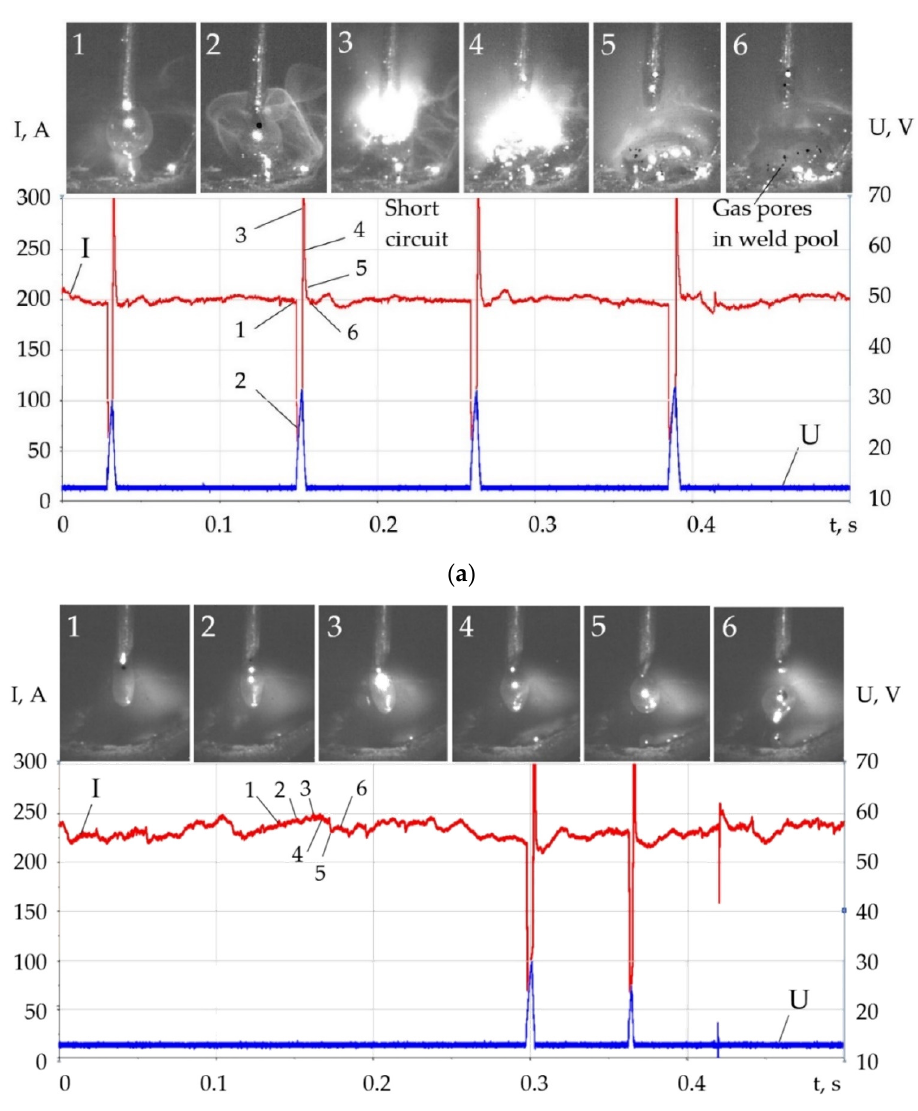
Figure 12. Change in the current and sequence of droplet transfer during melting of a 316L wire of 1.0 mm in argon: ( a ) uncoated wire; time between the frames is 1 ms; ( b ) wire with a Ni-LaB 6 coating of 5 μ m; time between the frames is 5 ms; 1–6 is a sequence of frames.